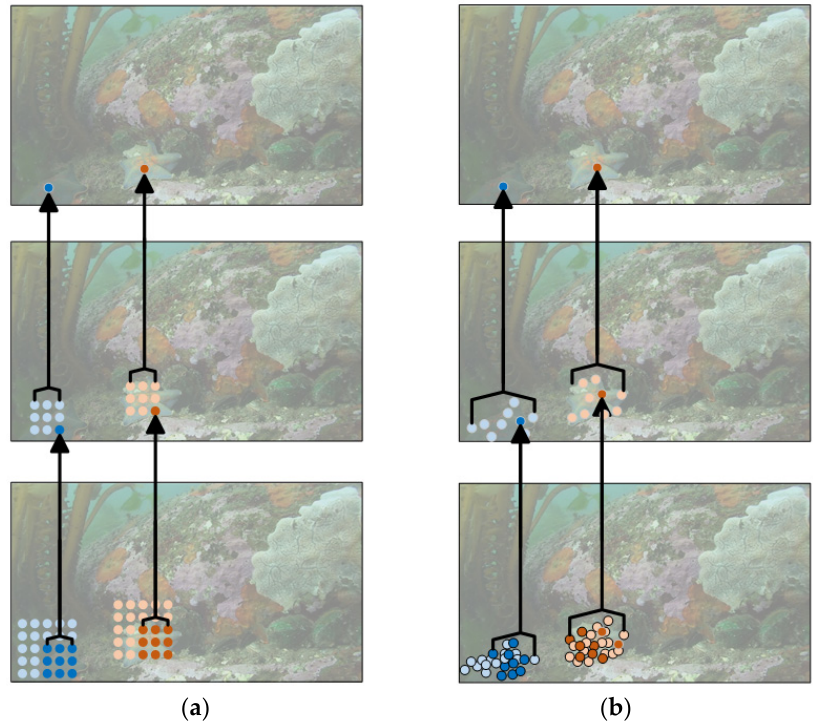
Figure 11. The deformable convolution adopted in this study: ( a ) Convolution is to calculate the pixels within a regular rectangular range and extract features. ( b ) Deformable convolution has one more position mapping matrix, which represents the convolution kernel and the pixel after position mapping for calculation.